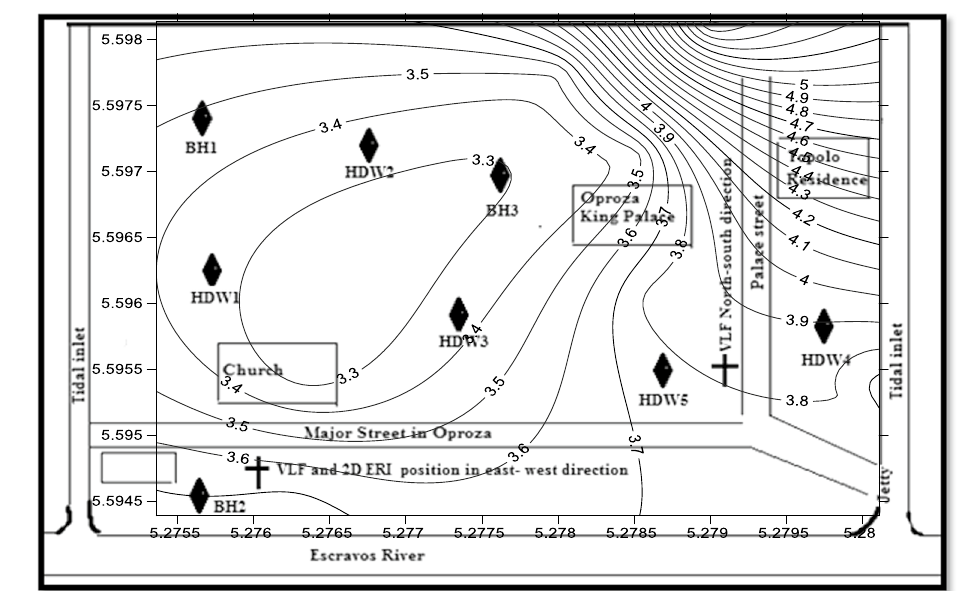
Fig. 7 Hydraulic heads showing groundwater flow direction